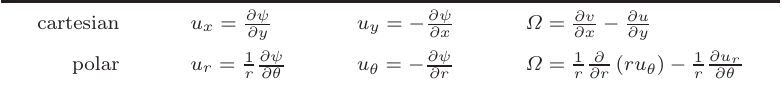
Table 1. Velocity and vorticity definitions.